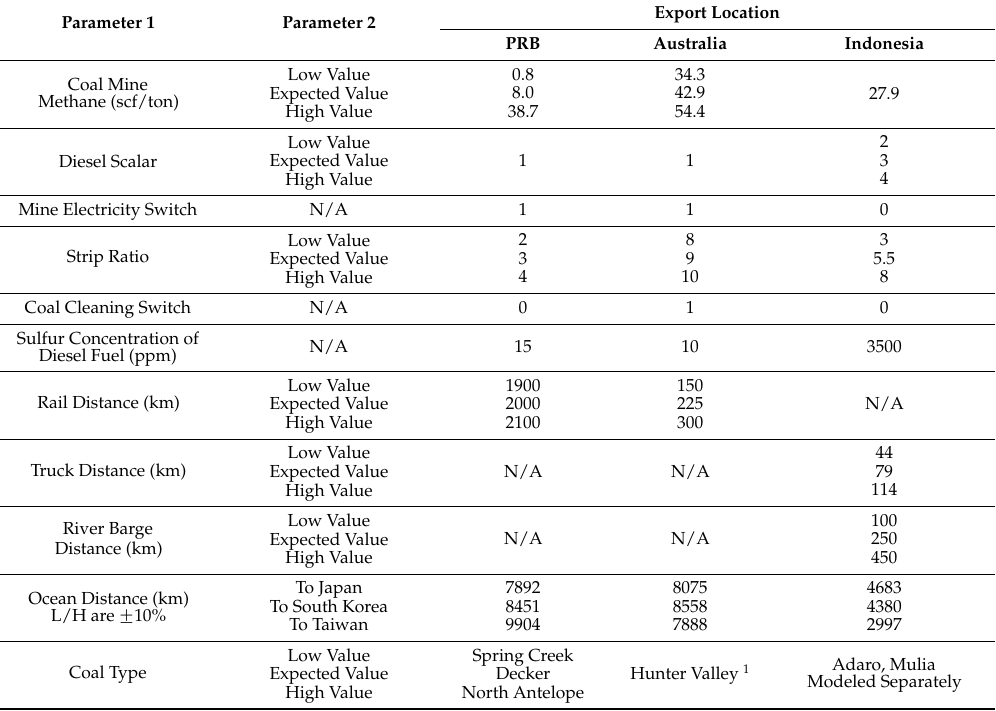
Table 2. Coal exports scenario parameter matrix.